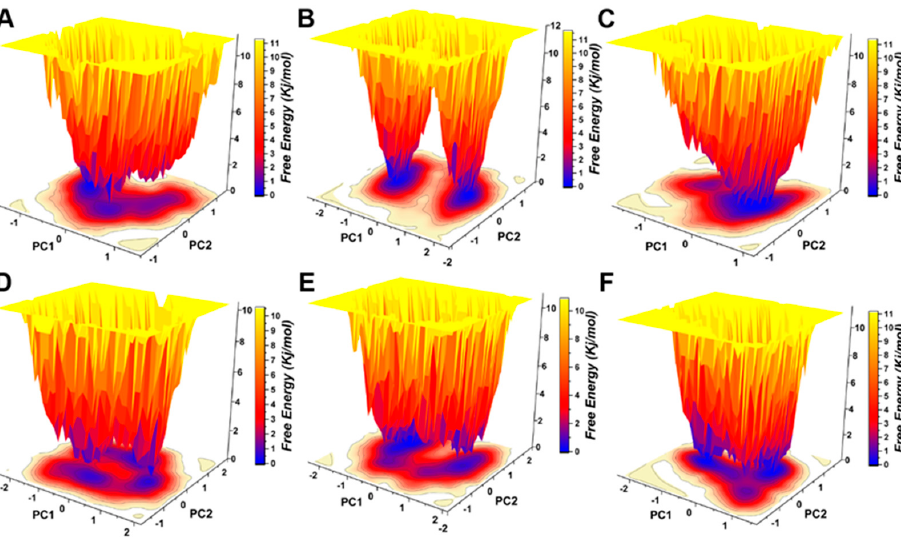
Figure 7. Free energy landscape analysis of the pS273R monomer and hypothetical drug molecular complexes. ( A ) Free pS273R monomer. ( B ) pS273R - Leucovorin complex. ( C ) pS273R - Carboprost complex. ( D ) pS273R - Proterelin complex. ( E ) pS273R - Flavin Mononucleotide complex. ( F ) pS273R - Lovastattin Acid complex.